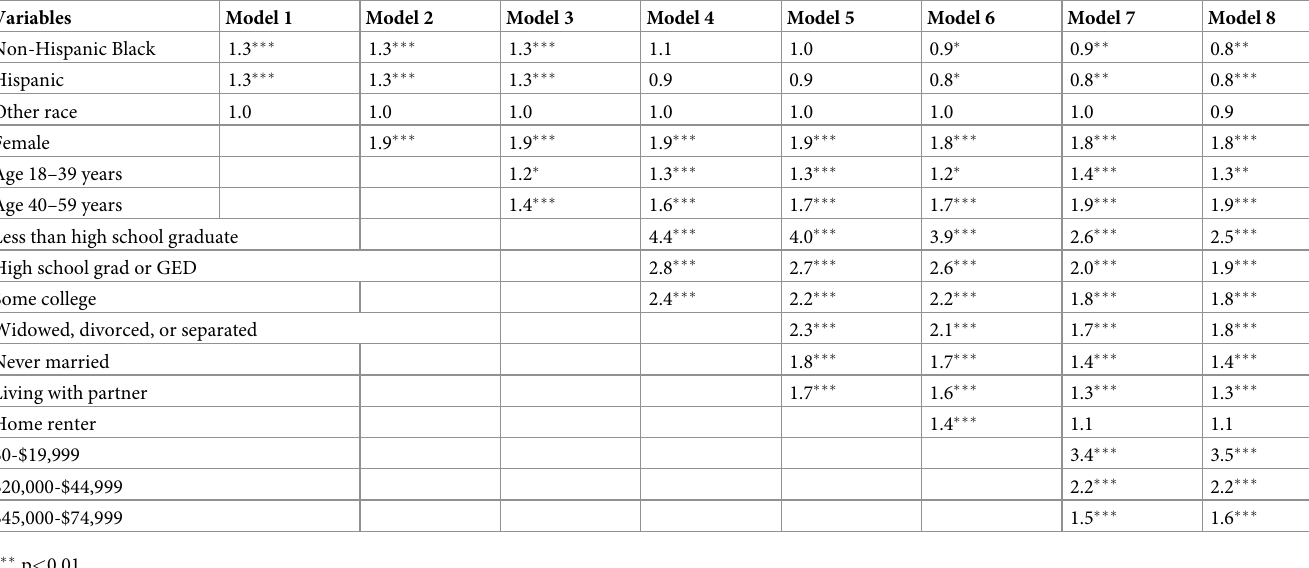
Table 3. Multivariable logistic regression of probable depression in U.S. adults with variables added in forward stepwise fashion (N =